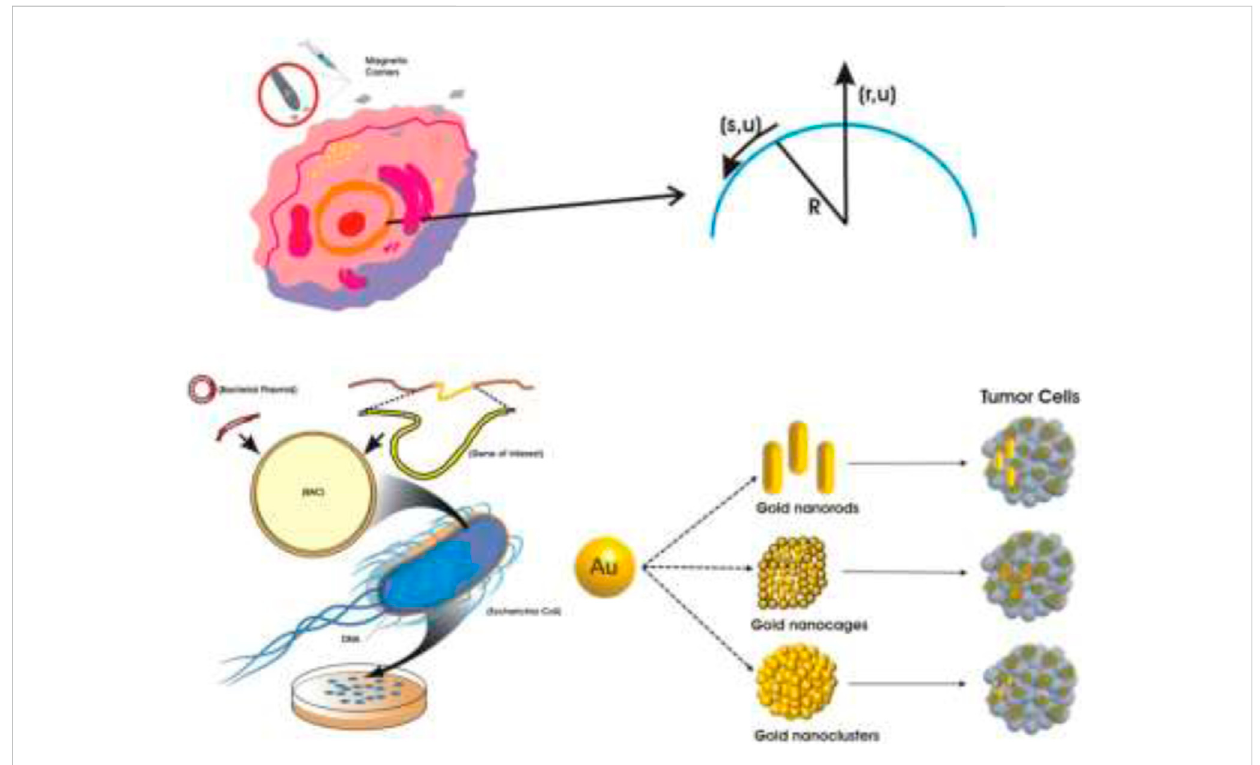
FIGURE 1 Fluid fl ow con fi guration and coordinate